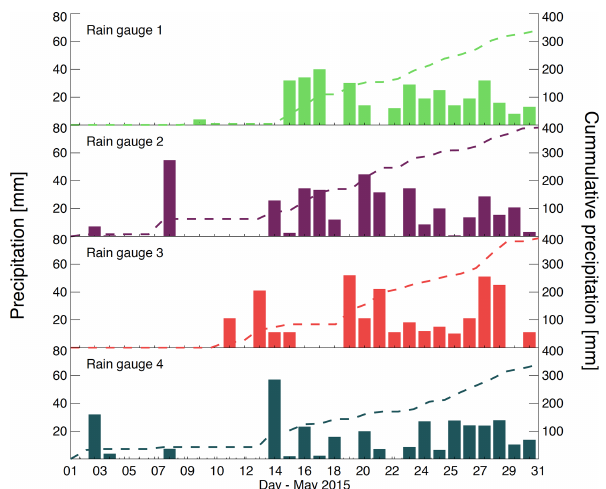
Figure 3. Daily precipitation during May 2015 near Salgar, recorded at the IDEAM in situ rain gauges shown in Fig. 1. Bars correspond to daily cumulative precipitation and the dashed lines to the evolution of the cumulative precipitation during May